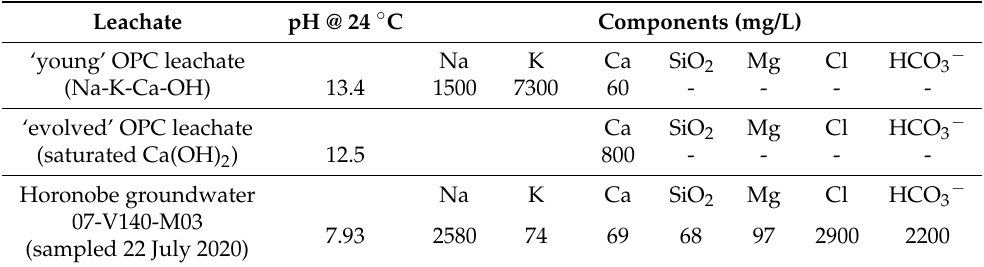
Table 1. Initial concentrations of major ions in the OPC leachates and Horonobe